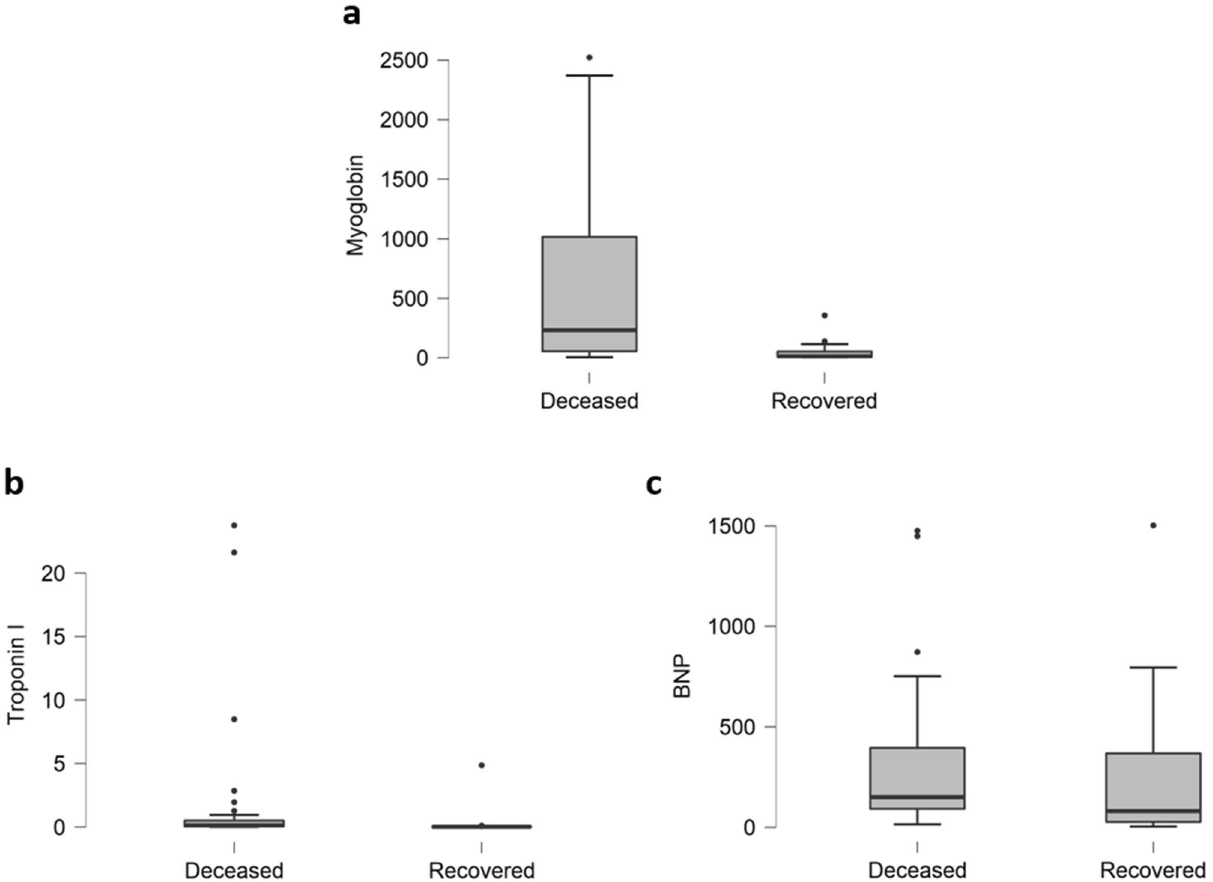
Figure 4. Cardiac parameters of deceased and recovered patients. Highly elevated levels of ( a ) Myoglobin, while slight elevations in Cardiac Troponin I ( b ) and B-Type Natriuretic Peptide-BNP ( c ) have occurred in deceased